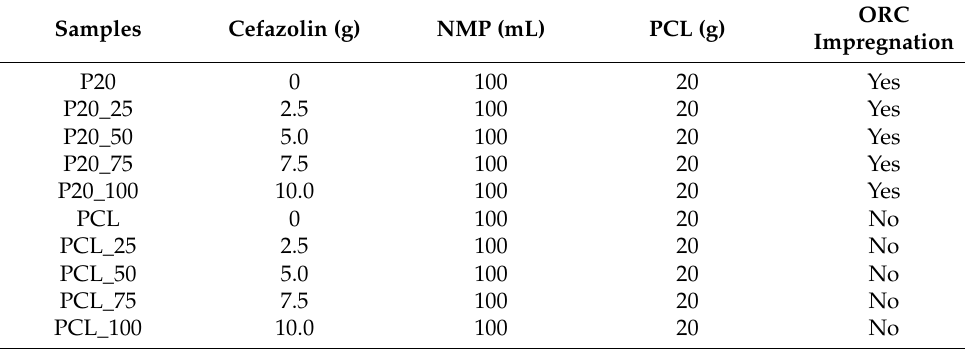
Table 1. Formulations of the prepared